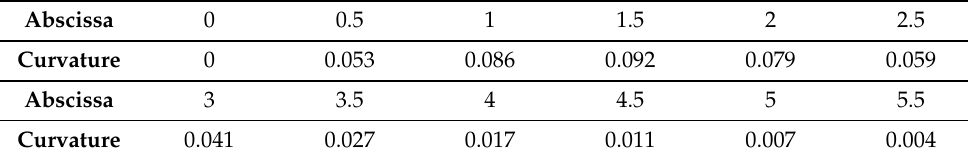
Table 1. Curvatures with different abscissas of the sigmoid function. Abscissa